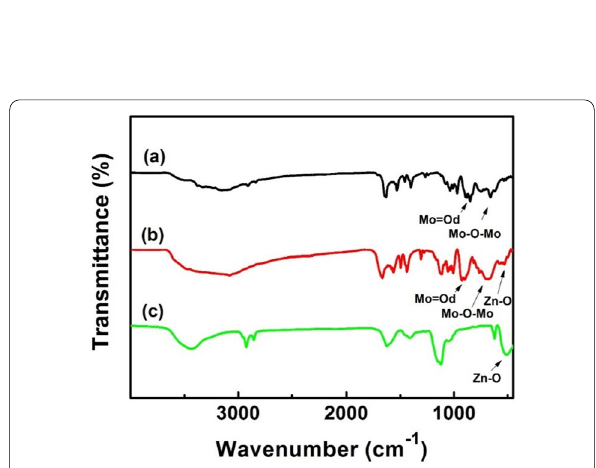
Fig. 3 FTIR spectra of a POMs, b AgZnO/POMs nanocomposites and c AgZnO hybrid